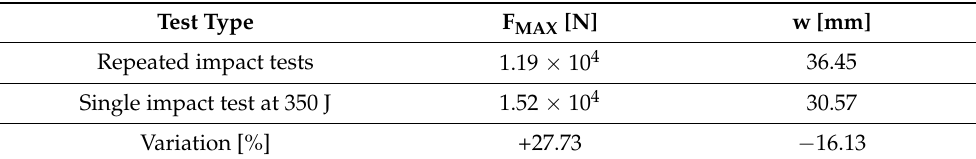
Table 4. Comparison between repeated impact tests and single impact test at 350 J for the Type IV panel.